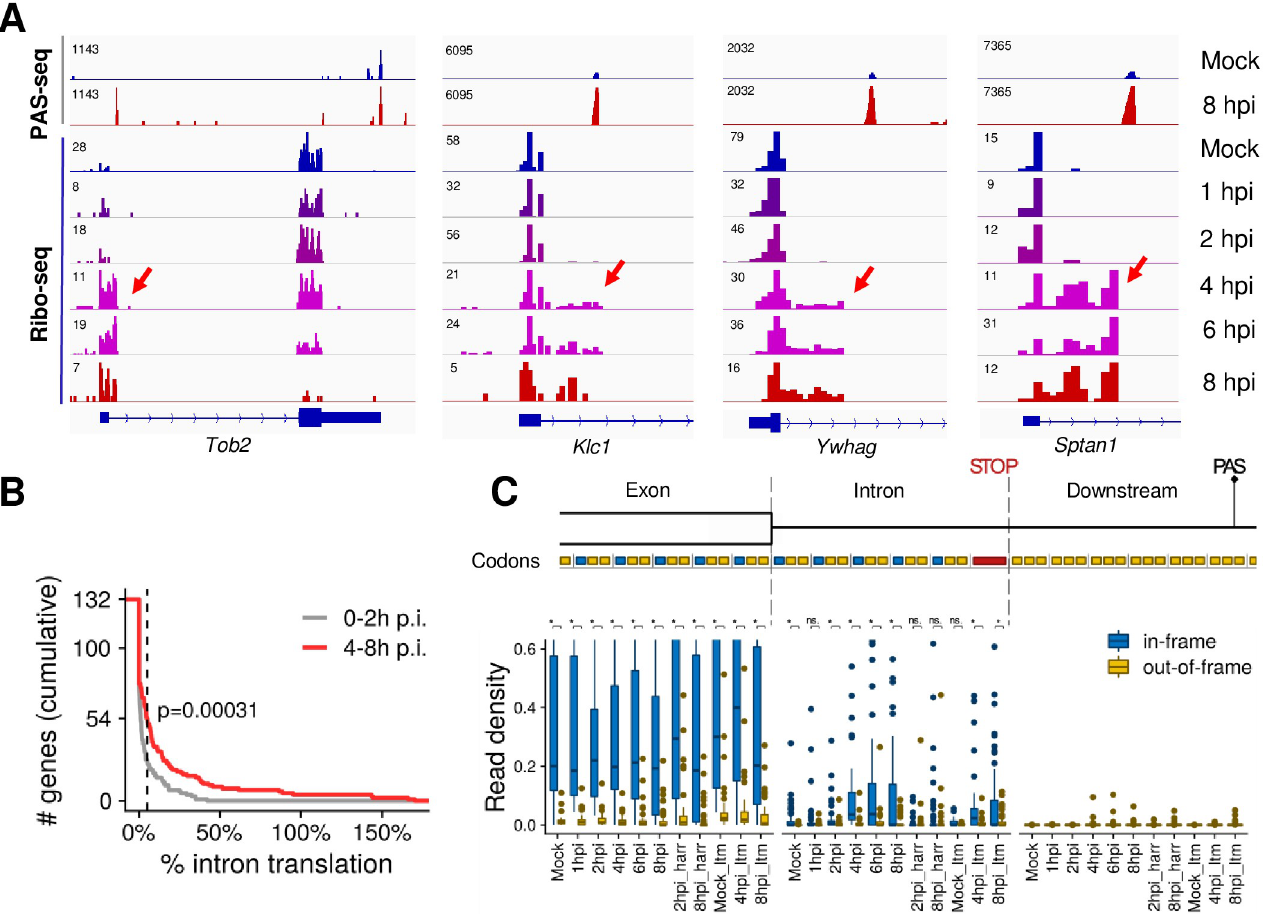
Fig 6. HSV-1-induced intronically polyadenylated APA isoforms are translated. (A) PAS-seq and Ribo-seq tracks for four example genes. Ribo-seq signals within intronic regions are marked by red arrows. (B) Cumulative distribution of the percentage of intronic Ribo-seq read densities (normalized reads per codon) compared to the level in the upstream exon. The dashed line indicates genes exceeding the 5% threshold mentioned in the text. The P value for comparing the pooled read densities in un-infected through 2 hpi vs. 4–8 hpi is shown (two-sided Kolmogorov-Smirnov test) (C) Boxplots showing the distributions of read densities for the 54 genes exceeding the 5% threshold stratified by time point after infection, location with respect to exon-intron boundary and first intronic stop codon, and reading frame of translation. The hinges and whiskers correspond to quartiles and to the most extreme values outside of 1.5 times the inter-quartile range, respectively. The median and outliers are indicated. The y axis is arbitrarily cut at 0.6. P values for comparisons of in-frame and out-of-frame codons are indicated ( ��� , p < 0.001; �� , p < 0.01; � , p < 0.05; n.s., not significant at 5% level).